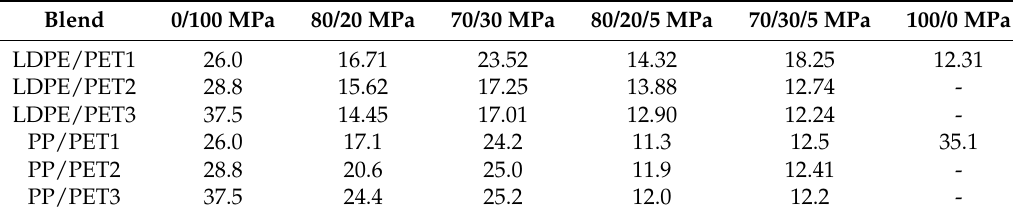
Table 6. The tensile strength of polymer